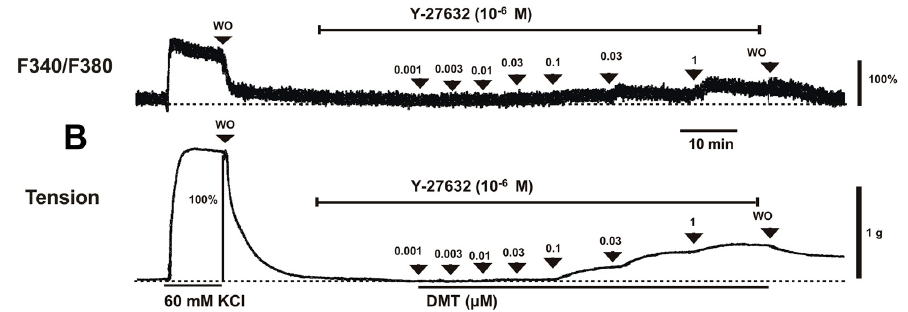
Figure 1. Effects of 60 mM KCl and dexmedetomidine (DMT) on the intracellular calcium concentration ([Ca 2+ ] i ) (upper trace) and muscle tension (lower trace) in the absence ( A ) and presence ( B ) of 10 − 6 M Y-27632 in endothelium-denuded rat aortas. The [Ca 2+ ] i of fura-2-loaded aortic strips was detected using a fluorometer and expressed as the F340/F380 ratio. After the effects of 60 mM KCl were determined, DMT (10 − 9 to 10 − 6 M) was cumulatively added. A value of 100% represents the 60 mM KCl-induced contraction or [Ca 2+ ] i increase measured before washout (WO) with Krebs solution.